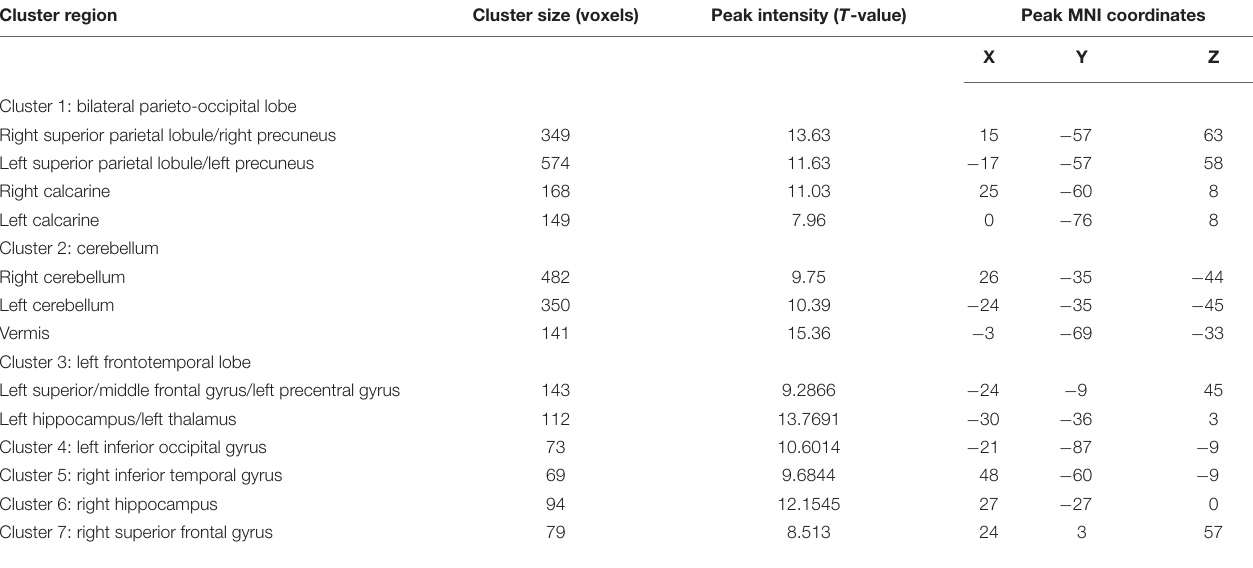
TABLE 1 | Detailed information about activation areas in GLM analysis. Cluster region Cluster size